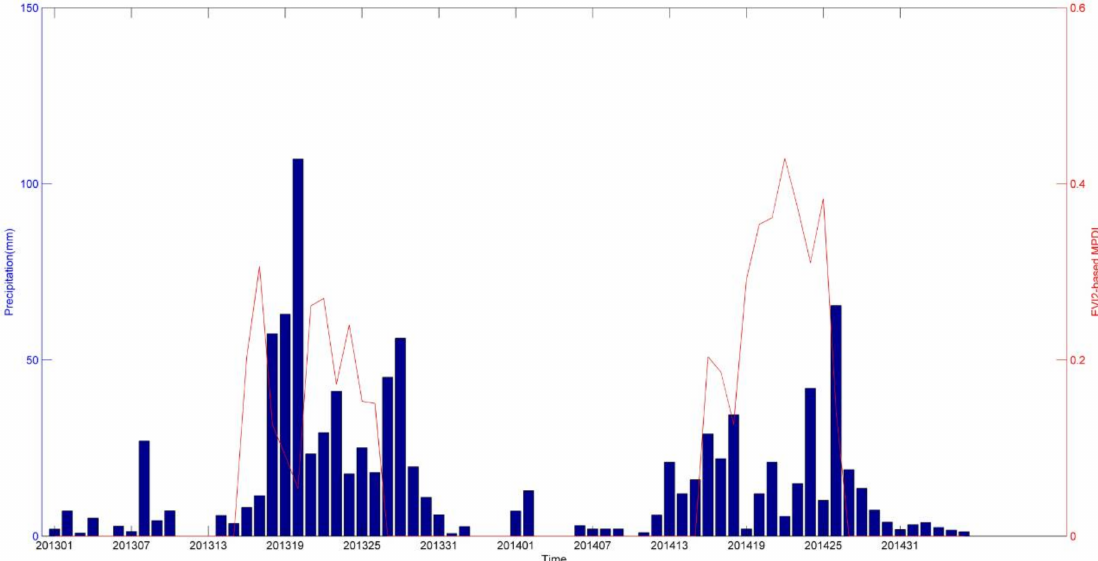
Figure 6. Temporal distribution of EVI2-based MPDI and precipitation during 2013 to 2014 at the Heishan meteorological